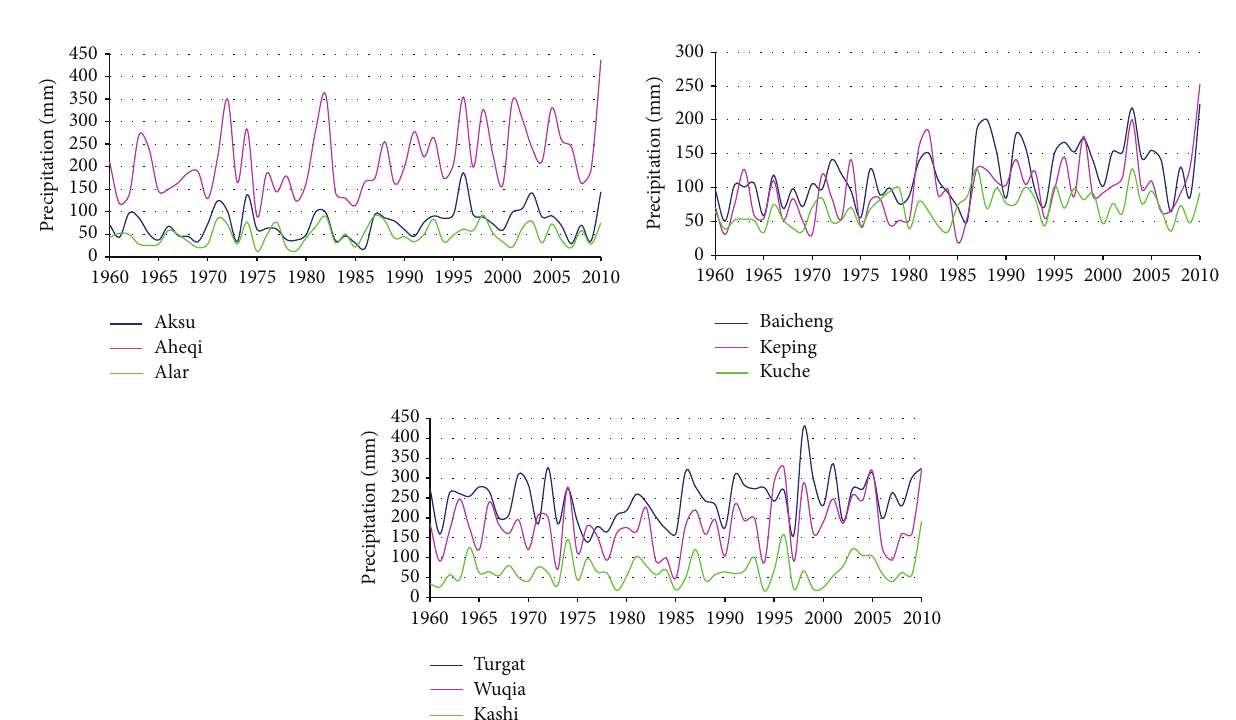
Figure 2: Annual precipitation time series at the 9 synoptic